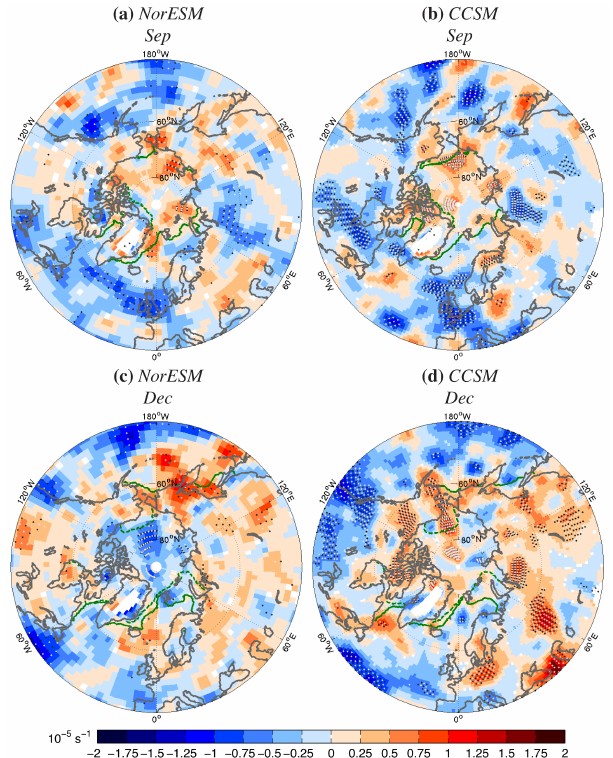
Figure 12. Changes in mean intensity averages for September (upper row) and December (lower row) 2074–2100 compared to 1979–2005 following the RCP8.5 scenario in (a, c) NorESM and (b, d) CCSM. Regions with track density below 0.5 no. density (month) − 1 (10 6 km 2 ) − 1 in the historical time period are shaded white. Alternating black and white dots mark regions where p < 0 . 05 based on 2000 samples. Solid and dashed green lines show the sea ice boundaries in each model and month over 1979–2005 and RCP8.5 2074–2100, respectively, calculated using a threshold of 15%